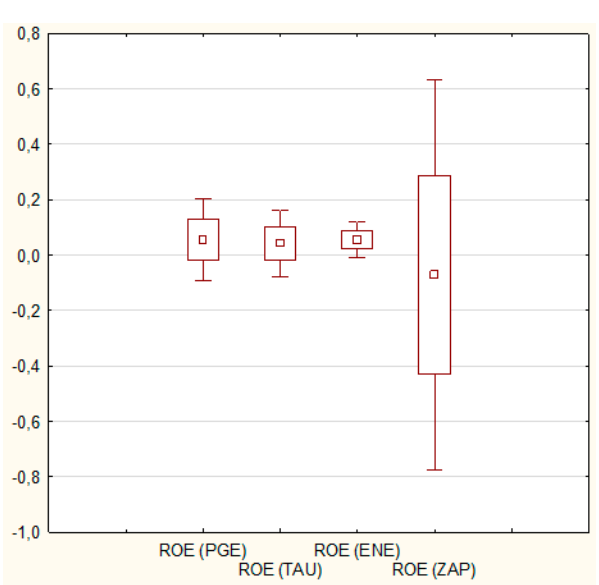
Figure 7. Box plot for ROE Source: Own elaboration.